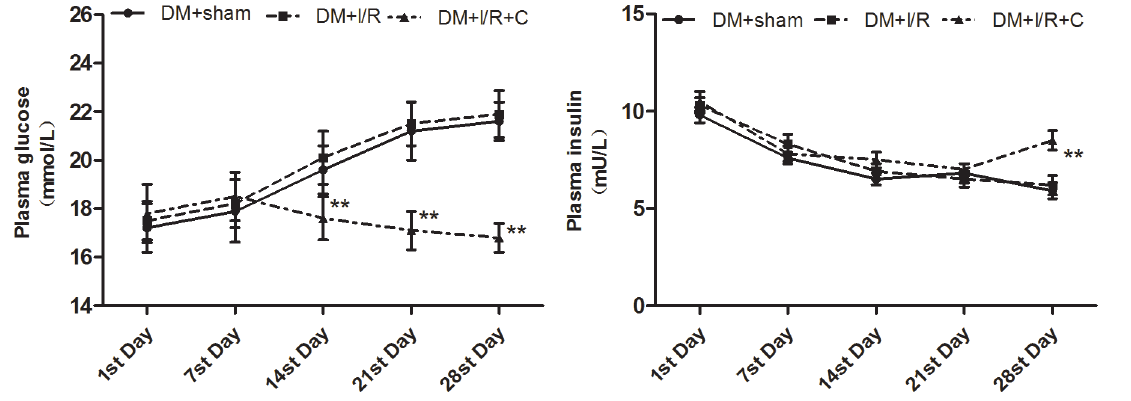
Figure 2. Effects of catalpol on plasma glucose and insulin levels. * P < 0.05 versus the DM+I/R group; ** P < 0.01 versus the DM+I/R